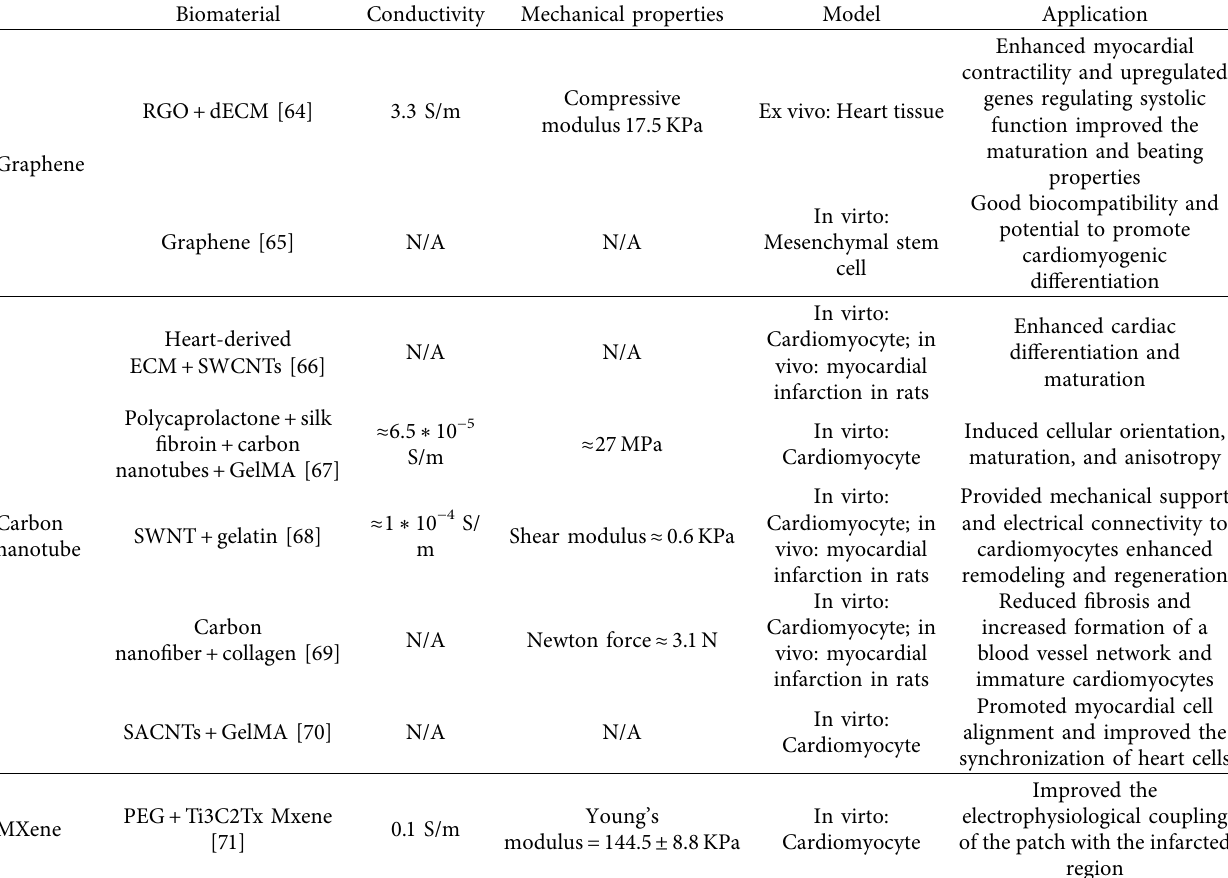
Table 2: Applications of carbon-based EHs in cardiac repair and regeneration.